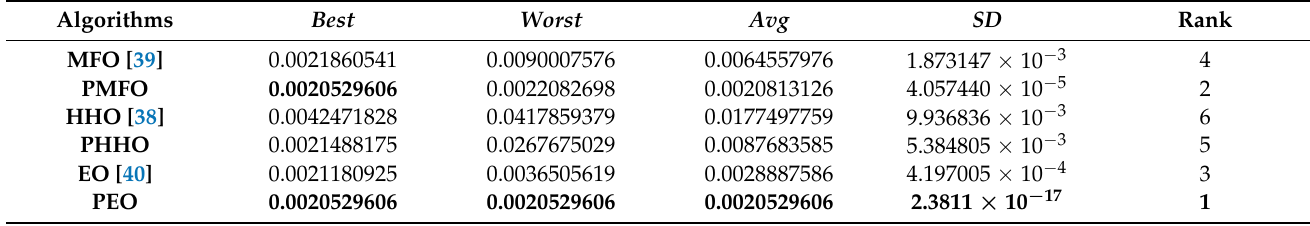
Table 5. Comparison under the extracted parameters per cell and the corresponding RMSE of Photowatt-PWP201. Algorithms